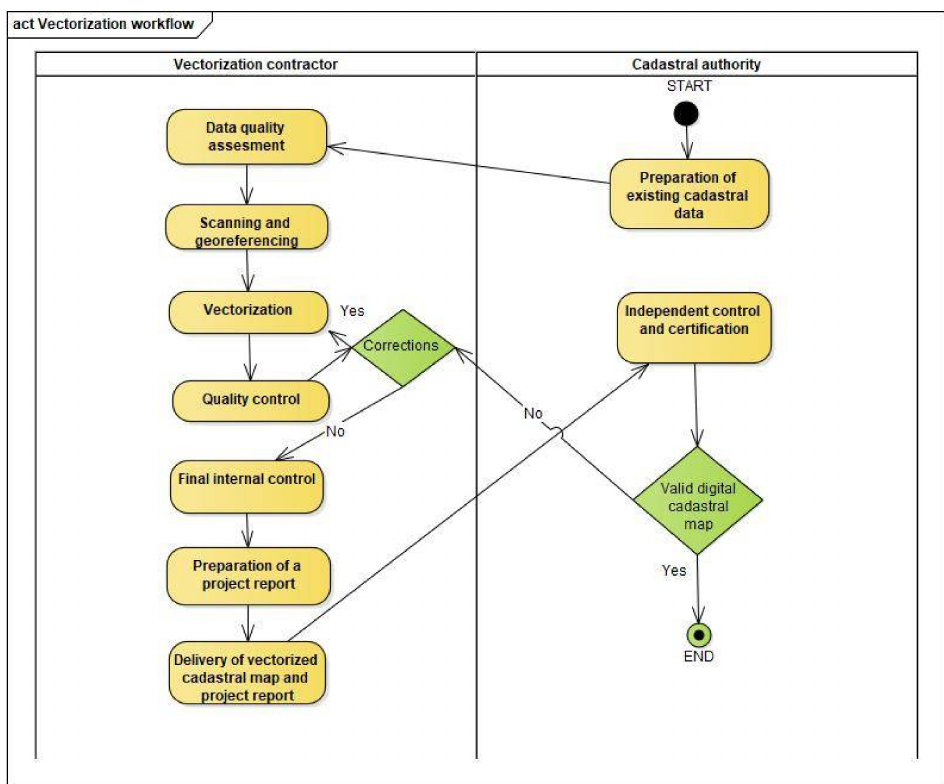
Figure 1. Vectorization flow diagram. Source: own